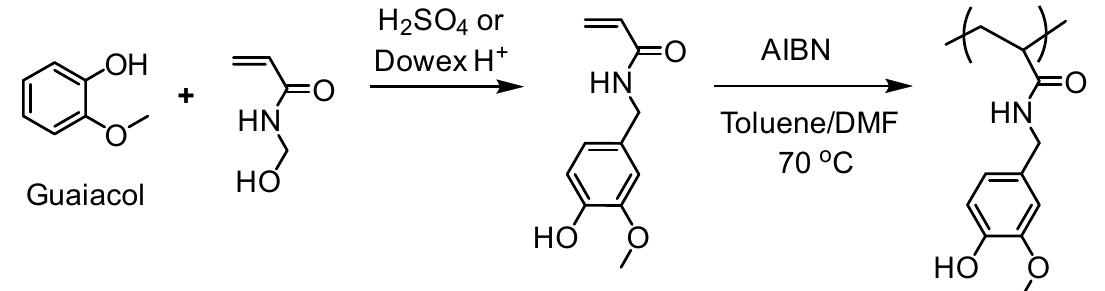
Figure 9. A guaiacol-based acrylamide monomer and polymers by FRP [43].